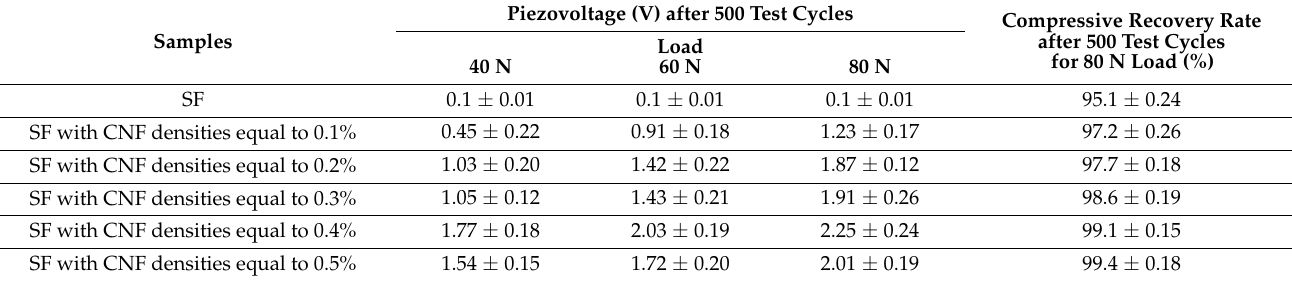
Figure 7. ( a ) Load Response analyses for the SF with CNF density equal to 0.4%; ( b ) Voltage Response analyses for the SF with CNF density equal to 0.4%; Piezoelectric voltage response on three different load levels of the SF sensor with CNF densities equal to: ( c ) 0.1%; ( d ) 0.2%; ( e ) 0.3%; ( f ) 0.4% and ( g ) 0.5%. Table 2. Generated piezoelectric voltage and compressive recovery of SF nanocomposite samples after 500 testing